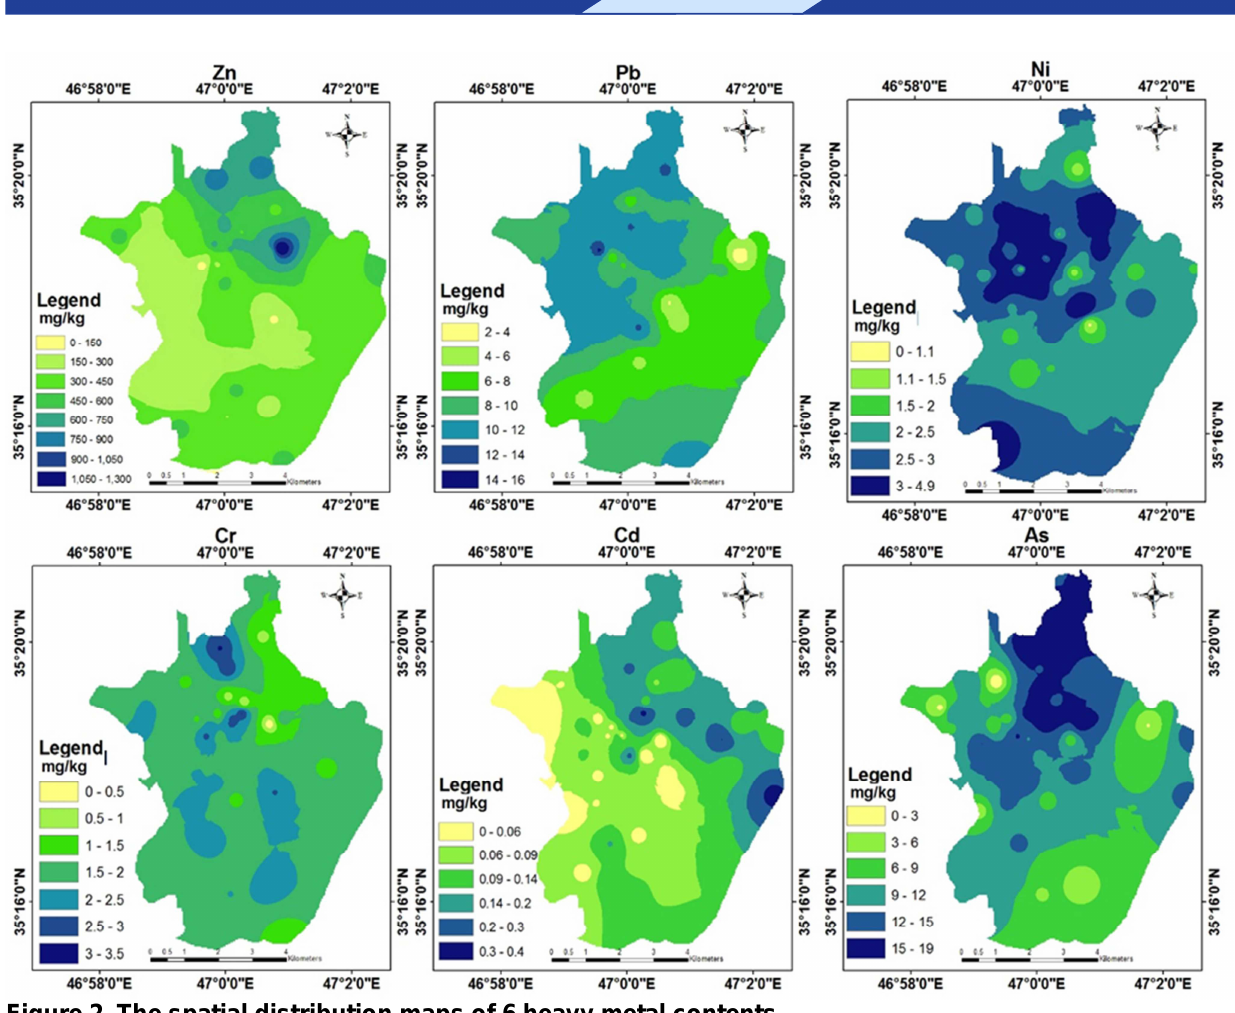
Figure 2. The spatial distribution maps of 6 heavy metal contents Table 3. Descriptive statistics parameters and tests of normality for roadside dust heavy metals Heavy metals